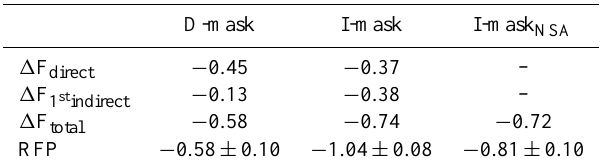
Table 1. Forcing ( 1 F) and radiative flux perturbation (RFP) for geoengineered sea-spray using the three different emission patterns (Wm − 2 ). The forcings are from 1-year runs using two calls to the model’s radiation scheme, while the RFP values are given as 10- year means ± one standard deviation. Separate forcing simulations for direct and indirect effects were not performed for the I-mask NSA case. D-mask